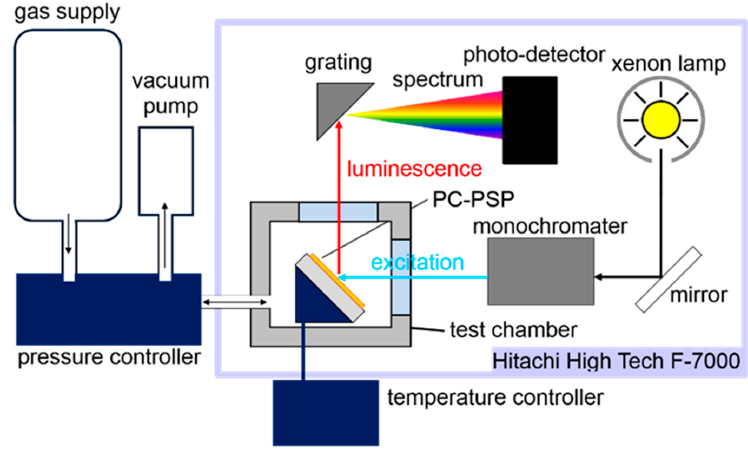
Figure 2. Schematic of static characterization setup.